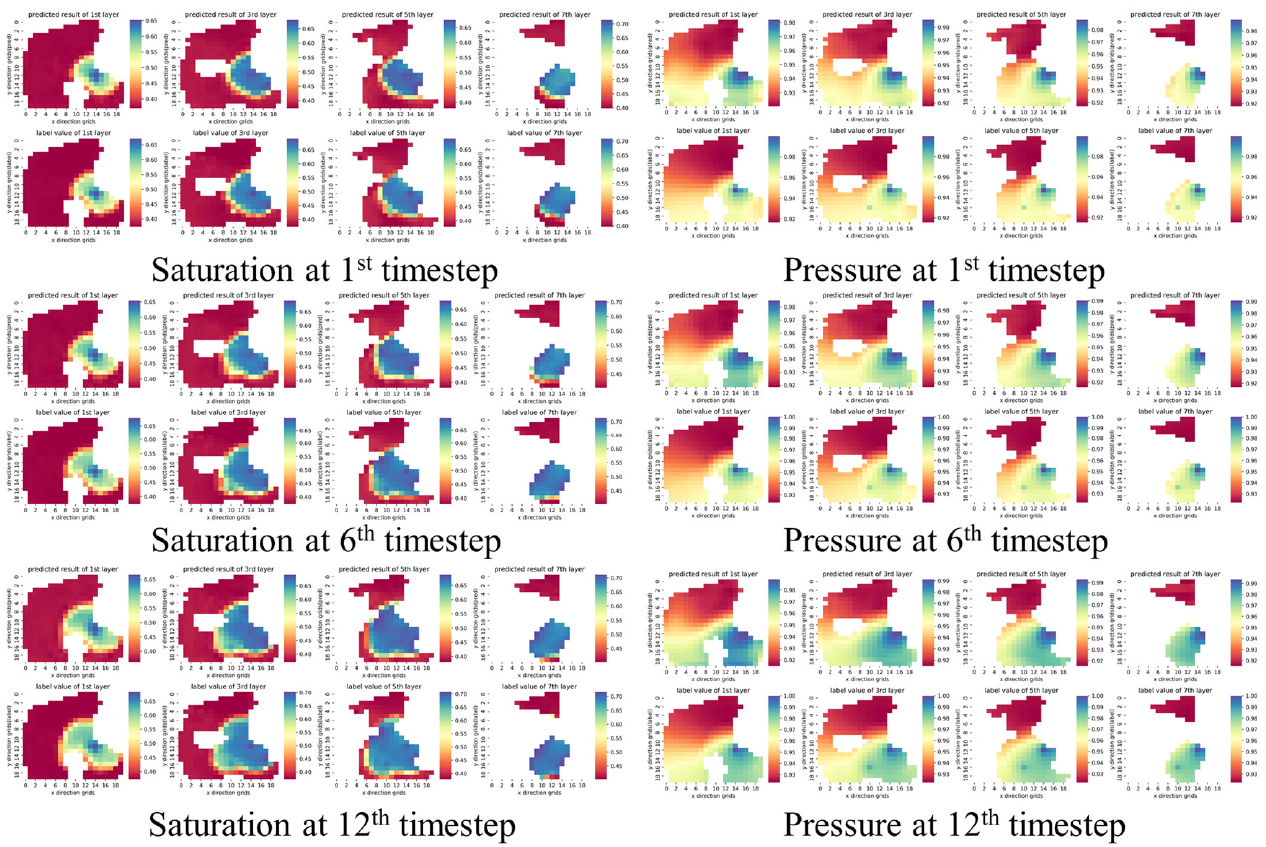
Figure 18. The prediction error for recurrently predicting saturation and pressure fields.